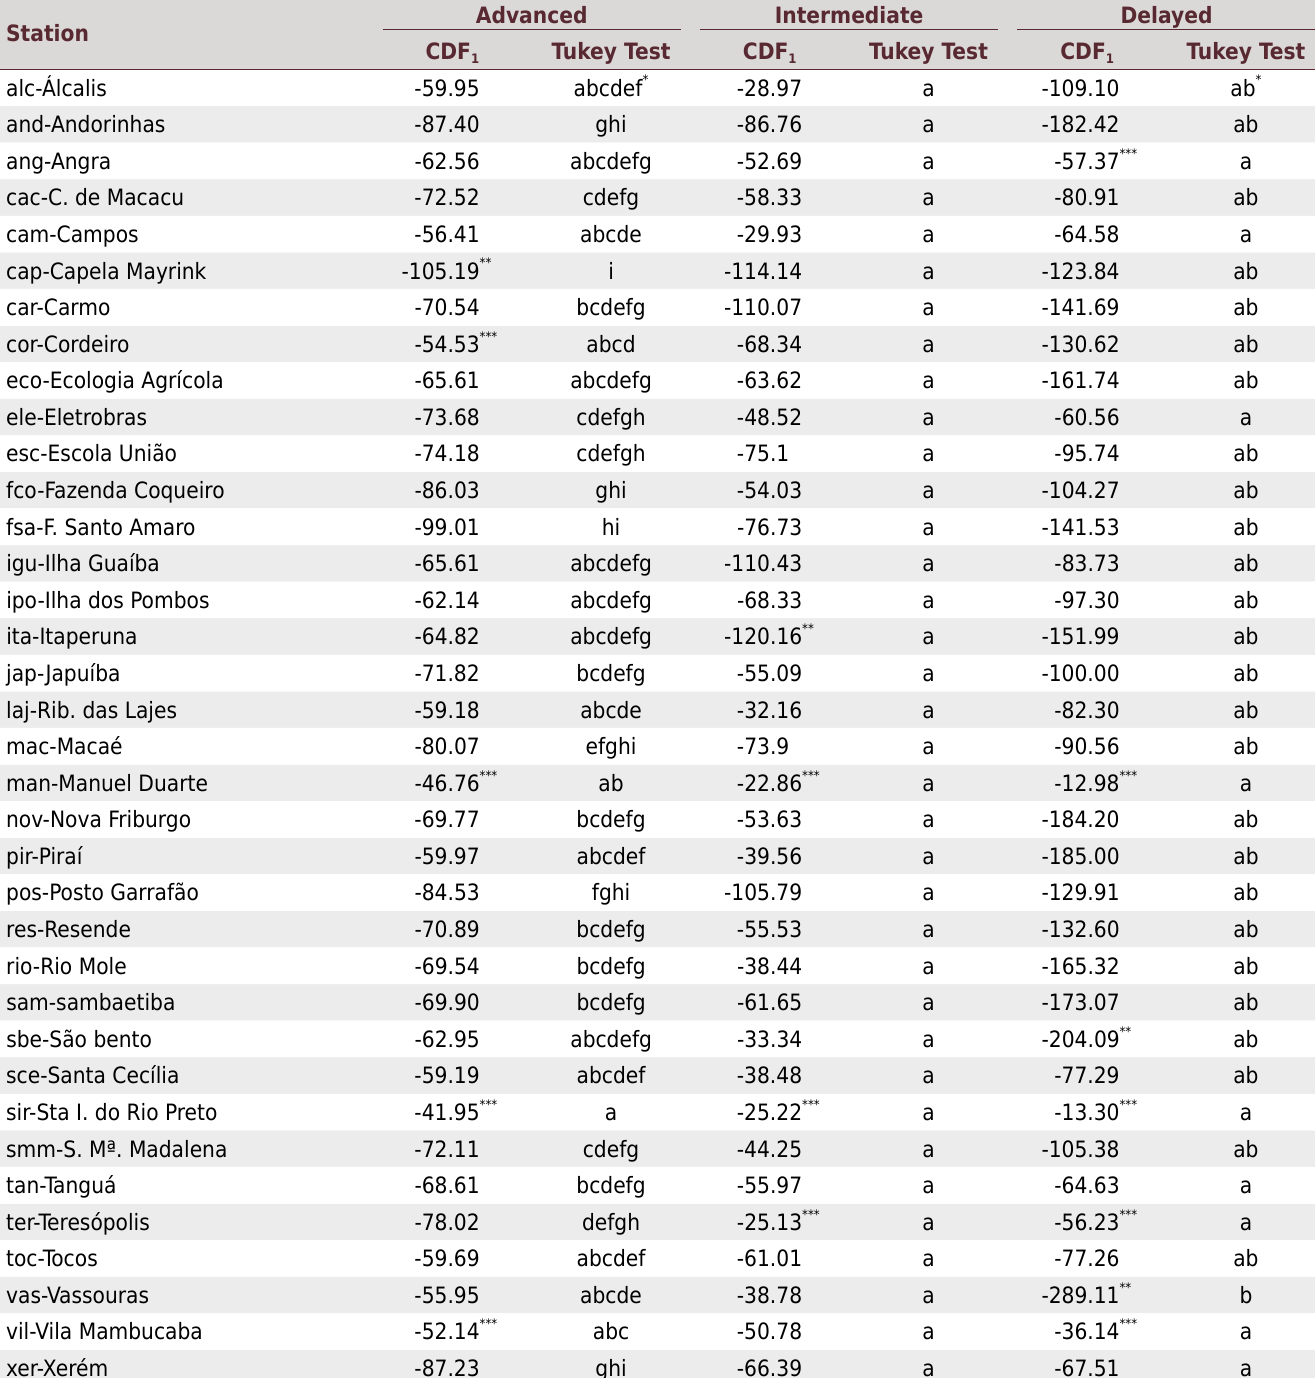
Table 5. Means of standardized canonical scores of the canonical discriminant function (CDF 1 ) of the physical characteristic and erosivity variables for the rainfall patterns